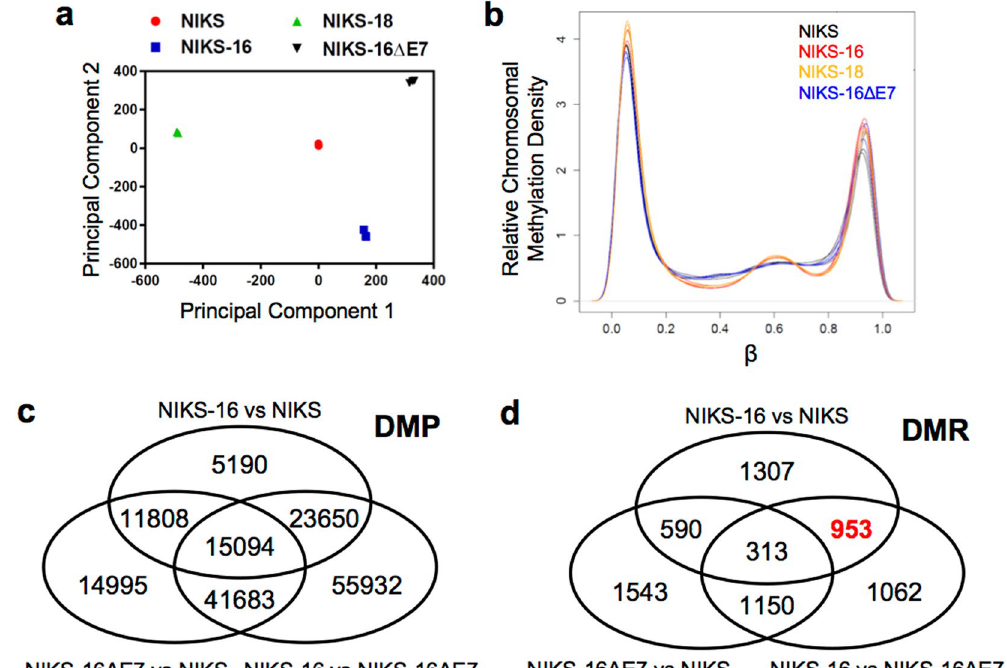
Figure 3. HPV16 E7 alters host genome methylation in keratinocytes. Global DNA methylation profiles in NIKS, NIKS-16, NIKS-18, and NIKS-16 Δ E7 cells were analyzed in triplicate using Illumina Infinium HumanMethylation450 BeadChip arrays. ( a ) Principal component analysis data are shown for each replicate of normalized data from NIKS (red circle), NIKS-16 (blue square), NIKS-18 (green triangle) and NIKS-16 Δ E7 (black triangle) cells. ( b ) Methylation array data from NIKS (black), NIKS-16 (red), NIKS-18 (orange) and NIKS-16 Δ E7 (blue) cells were normalized using SWAN and the relative methylation ( β ) density across the genome are plotted. β represents the ratio of methylated signal to total signal (methylated + unmethylated) at a given CpG site. β near 0 or 1 indicates no methylation or complete methylation, respectively. Three pairwise comparisons are summarized by Venn diagrams showing the number of overlapping ( c ) differentially methylated positions (DMP, FDR adjusted p < 0.05) and ( d ) differentially methylated regions (DMR, permutation p < 0.05). DMPs are defined as a single differentially methylated CpG site between groups while DMRs consist of at least two CpG sites separated by no more than 500 bp meeting the cutoff determined by bumphunter algorithm and permutation p -value <